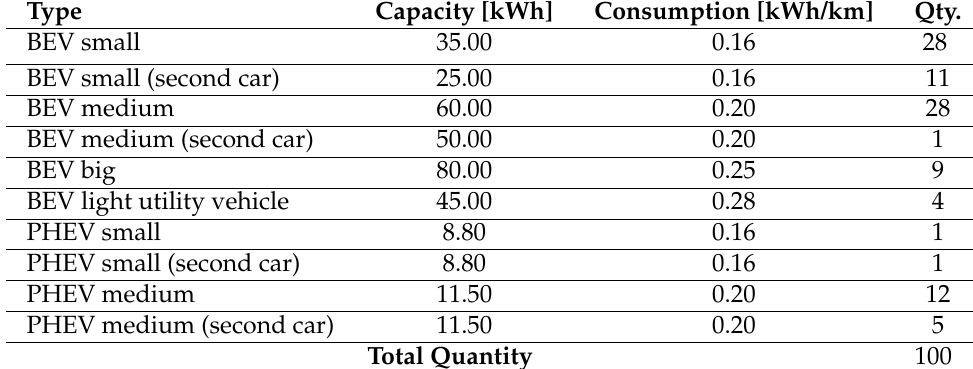
Figure 5. Maximum possible charging load of all 100 EVs , based on the presence of EVs at their home parking lot and the maximum charging power of every single EV . Table 3. Overview of characteristics and amount of EVs